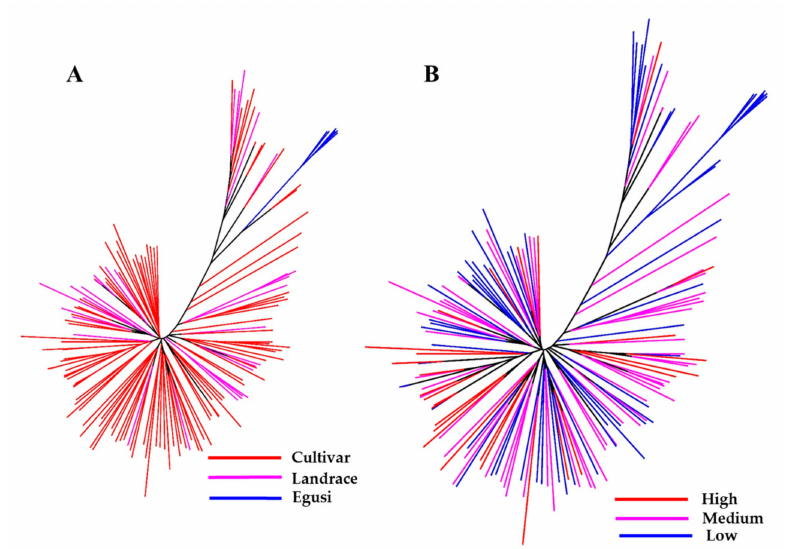
Figure 3. Genetic relationship between a set of 187 watermelon accessions. Neighbor-joining (NJ) tree constructed with 1410 high-quality SNPs explains most of the genetic structure of watermelon germplasm by ( A ) type and ( B ) citrulline content. Accessions in blue-, pink-, and red-colored clades are egusi-types, sweet watermelons, and landraces, respectively. In ( B ), blue, pink, and red clades represent low, medium, and high citrulline content,